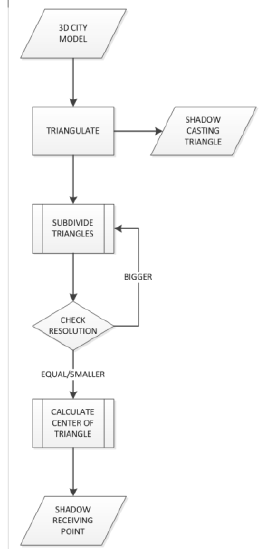
Figure 3: Processing 3D city model to make input data for Solar Potential Calculation.